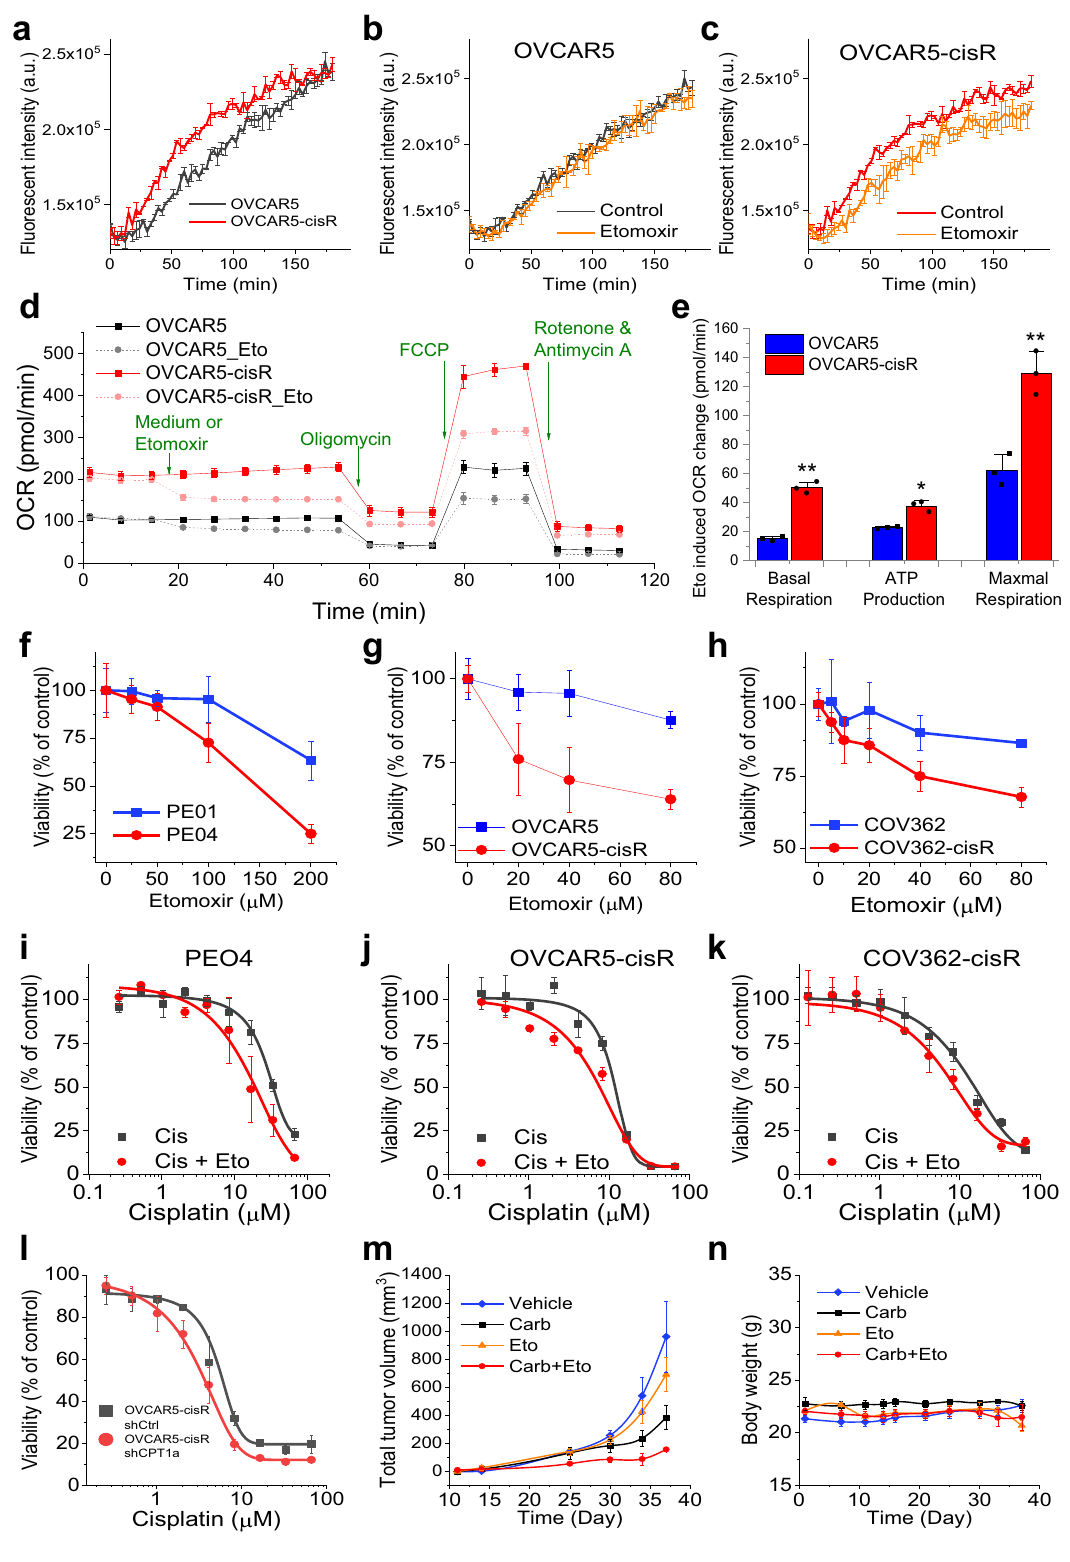
(Fig. 5h), indicating higher dependence on FAO in cisplatin-resistant cells. Next, we tested whether etomoxir treatment could reduce resistance to cisplatin. Our data show that the dose-response to cis- platin curves were signi fi cantly left shifted with etomoxir treatment in PEO4 (Fig. 5i), OVCA5-cisR (Fig. 5j), and COV362-cisR cells (Fig. 5k) and support potentially using etomoxir to re-sensitize resistant OC cells to